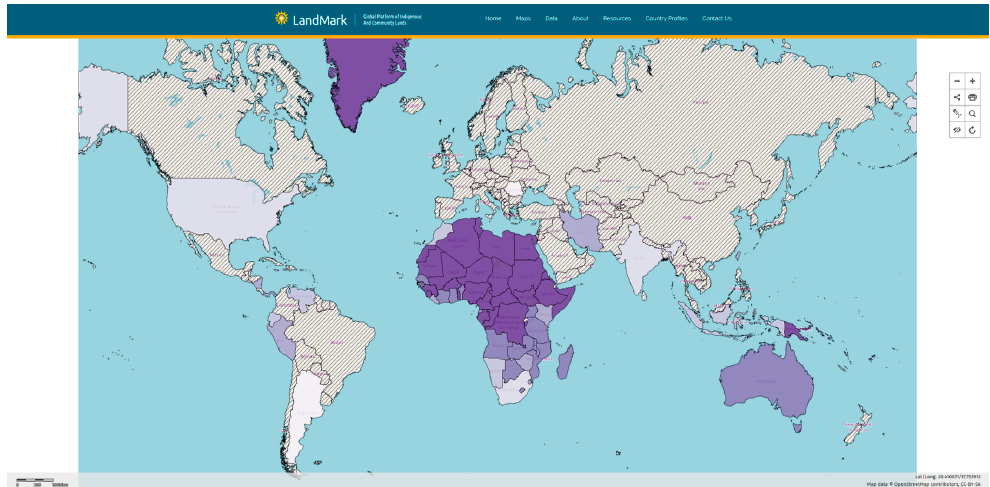
Figure 1. Slowly Discovering a Massive Community Land Resource (as of 2015). Note: The darker the shade, the higher the percentage of country area that is the land of communities (including Indigenous Peoples). The darkest shade is where these lands are estimated to constitute 80 percent or more of the country area. Community/Indigenous Peoples lands may, or may not be, recognized as owned in national laws [21]. Source: Screenshot from the publicly- available site on community and Indigenous Peoples land: www.landmarkmap.org.